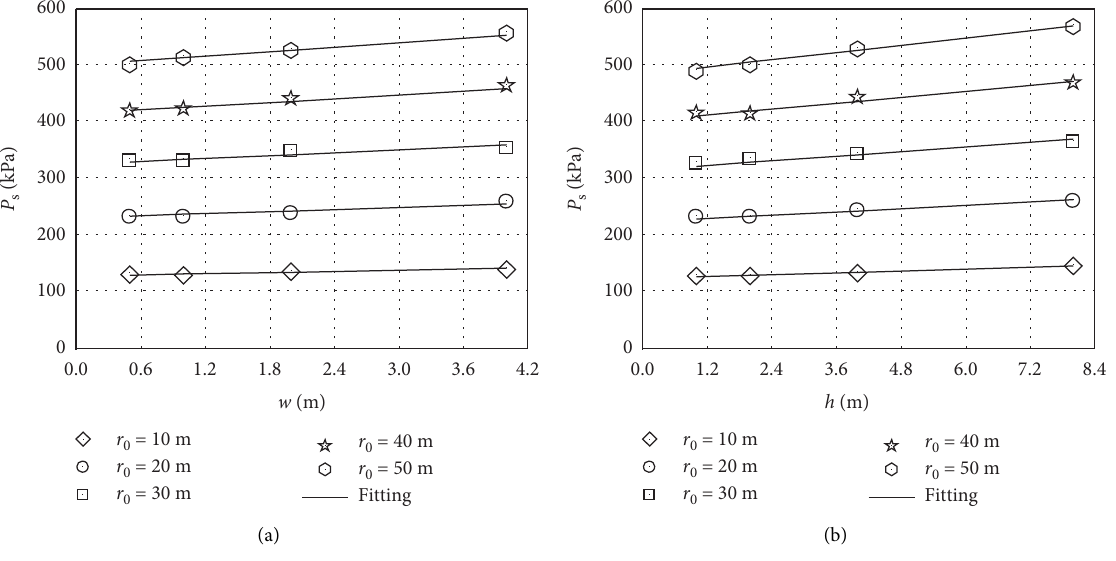
Figure 9: Relation between p